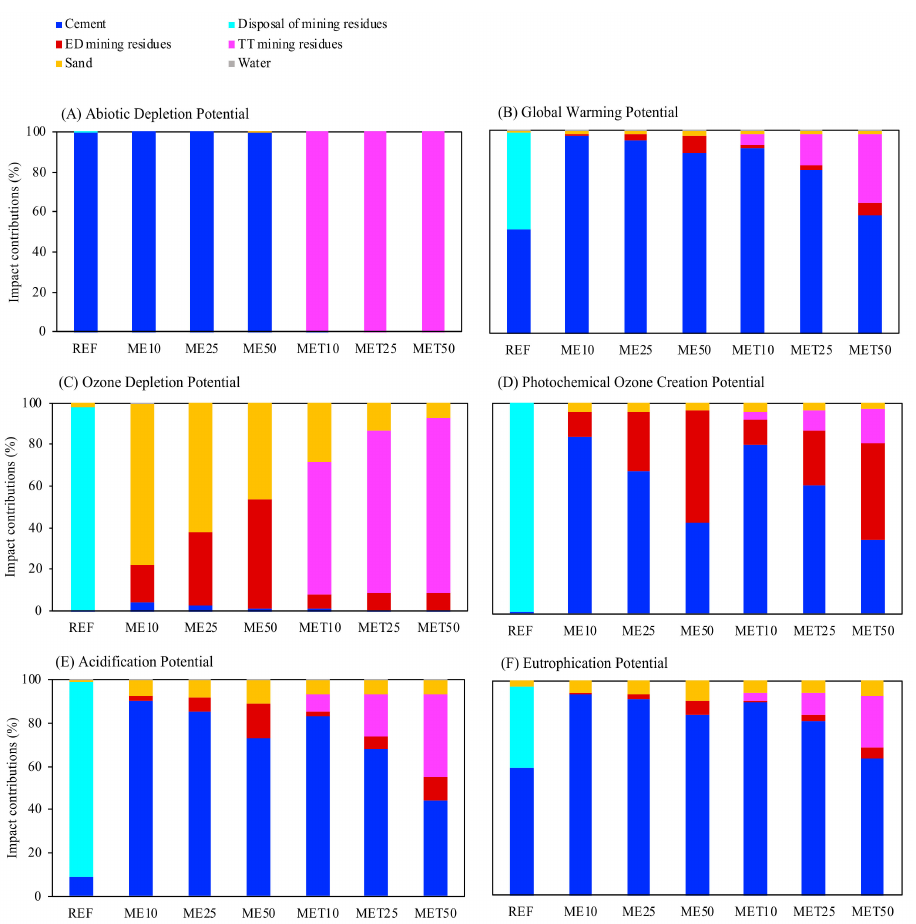
Figure 3. Contribution of mortars’ constituents for the environmental impacts in the categories anal- ysed: ( A ) Abiotic Depletion Potential; ( B ) Global Warming Potential; ( C ) Ozone depletion Potential; ( D ) Photochemical Ozone Creation Potential; ( E ) Acidification Potential; and ( F ) Eutrophication